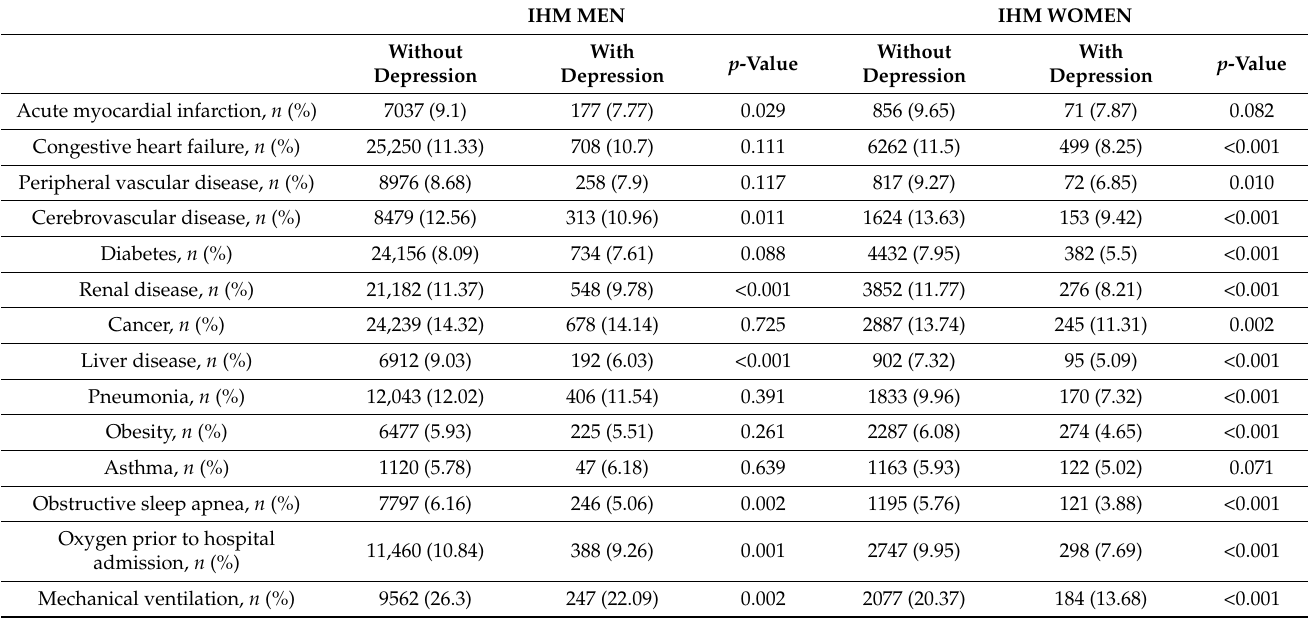
Table 4. In-hospital mortality among men and women hospitalized with COPD in Spain 2016–2020, according to selected concomitant condition and to the presence of depression.